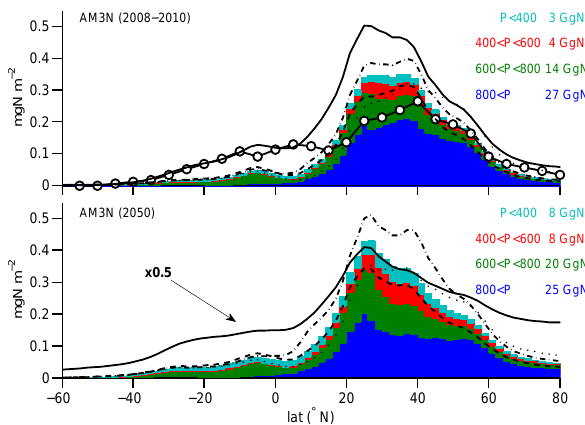
Figure 12. Annual zonal mean distribution of NO − with 2008–2010 anthropogenic emissions (top) and 2050 anthro- pogenic emissions (from RCP8.5 except for NH 3 ; see text). The blue, green, red, and cyan regions denote the NO − above 800hPa, between 600 and 800hPa, between 400 and 600hPa, and below 400hPa, with the partial burden in each pressure range indicated inset. The annual mean zonal burdens of NO − lated using AM3N_fdep_diu (dashed line), using AM3N with an- thropogenic emissions from RCP8.5 for NH 3 (dotted line), using AM3N_ndust (dashed dotted line), and using AM3N with reduced convective removal of NH 3 (solid line) are also shown. The white circles in the top panel indicate the 2000 annual zonal mean NO − burden simulated by Hauglustaine et al.